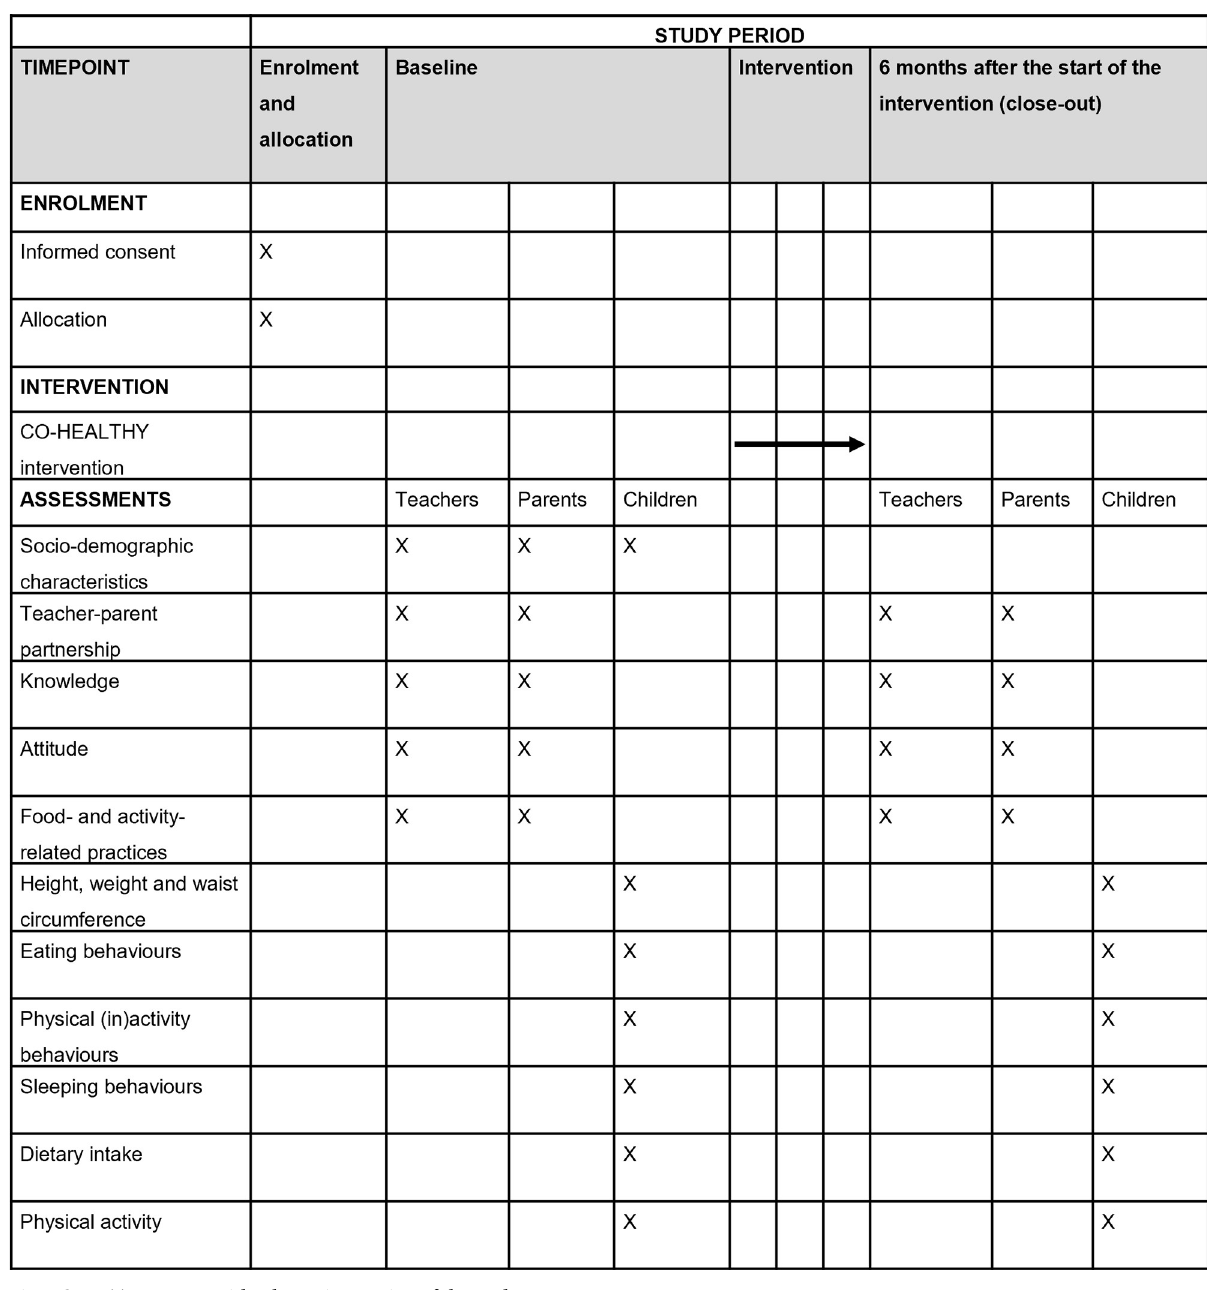
Fig 1. SPIRIT statement with schematic overview of the